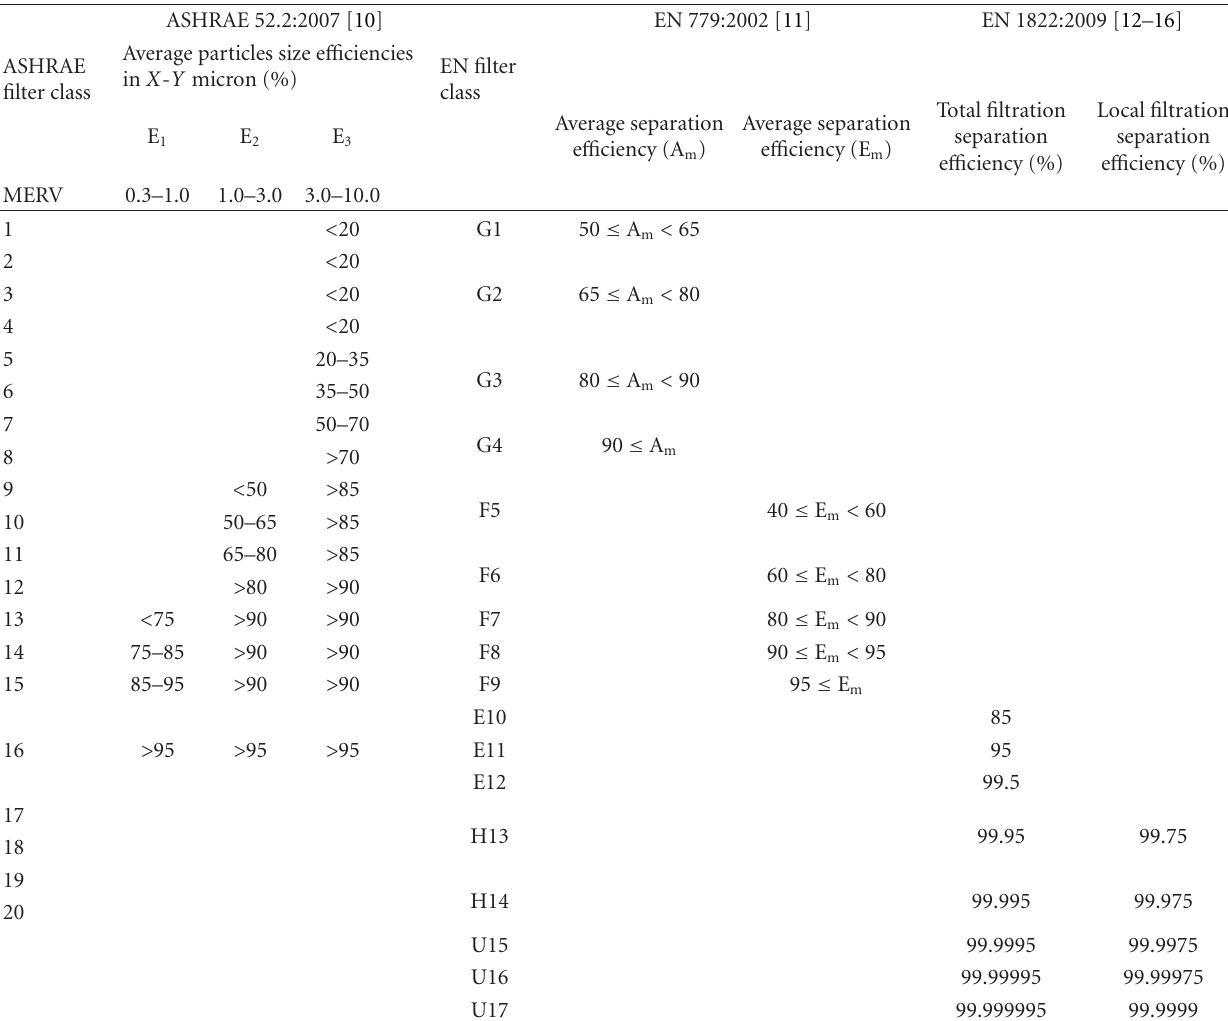
Table 1: Summary of filter classification for ASHRAE 52.2:2007 [10], EN 779:2002 [11], and EN 1822:2009